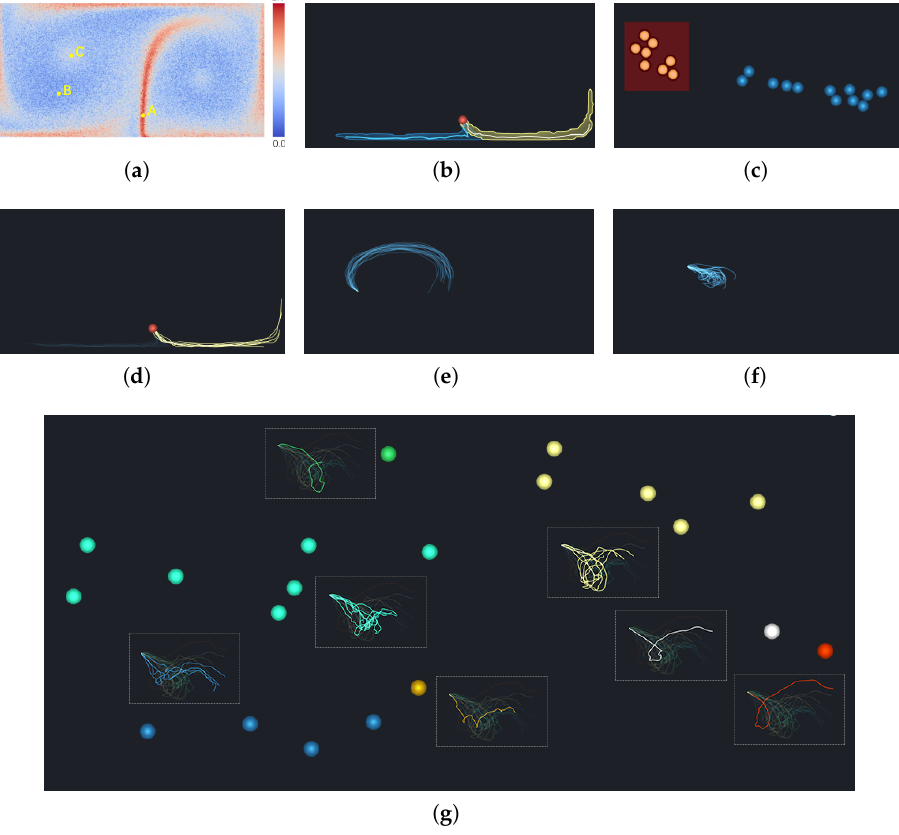
Figure 10. Transport patterns in the DG data set: ( a ) Rendering of local uncertainty (LU), ( b ) Transport pattern of location “A”, ( c ) Projection view of location “A” with selected points, ( d ) Selected trend, ( e ) Transport pattern of location “B”, ( f ) Transport pattern of location “C”, and ( g ) Hidden transport trends of location “C” revealed by brushing specific